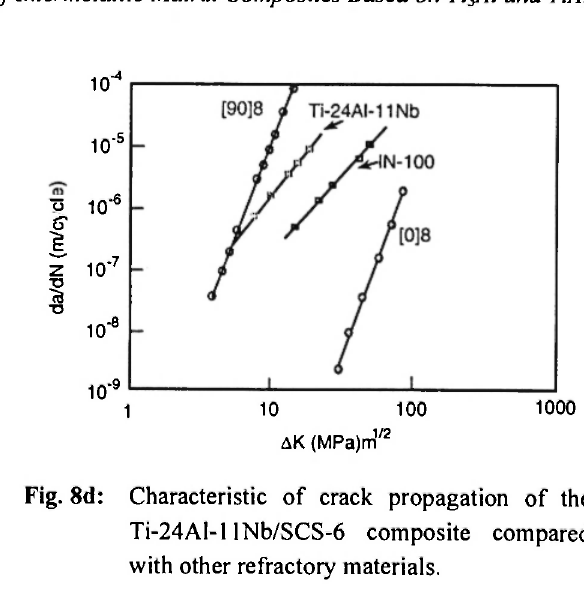
Fig. 8d: Characteristic of crack propagation of the ΤΪ-24ΑΙ-1 lNb/SCS-6 composite compared with other refractory